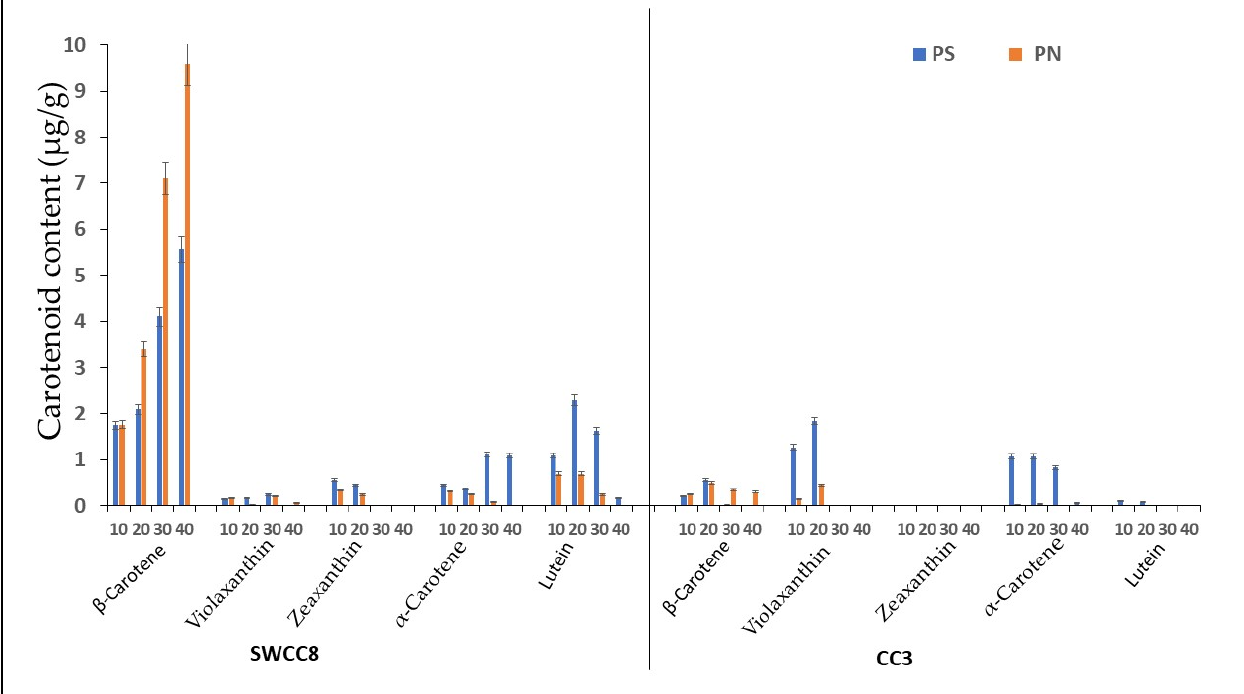
Figure 1. Carotenoid content ( μ g/g) and composition in the endocarp of WCC8 and CC3 under photoperiodic regimes. Data are means ± sd from analysis of carotenoid content in the endocarp of WCC8 and CC3 under two photoperiods. Vertical error bars represent the standard error of means ( n = 3); 10, 20, 30, and 40 are days after pollination; PS—short day photoperiod; PN—Neutral day photoperiod.